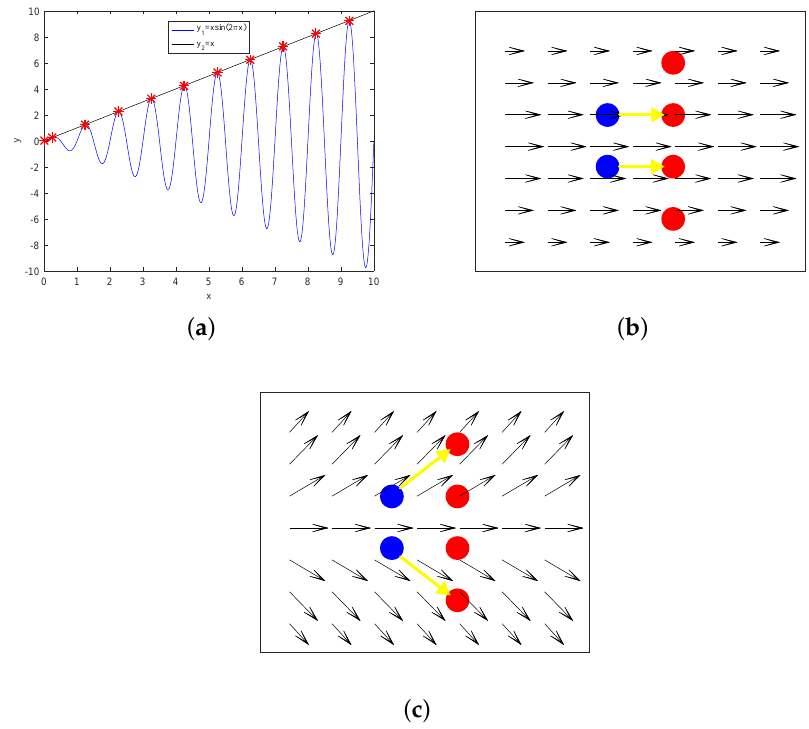
Figure 5. Two examples for demonstrating the importance of regularization. ( a ) two different results for a function estimation problem. The black line and blue curve denote the estimated functions with or without being regularized, respectively. In addition, the red asterisks denote 11 data points; ( b ) point set transformation and its velocity field in regularized scenario; ( c ) point set transformation and its velocity field in a non-regularized scenario. In ( b , c ), the blue and red points denote the source and target point,